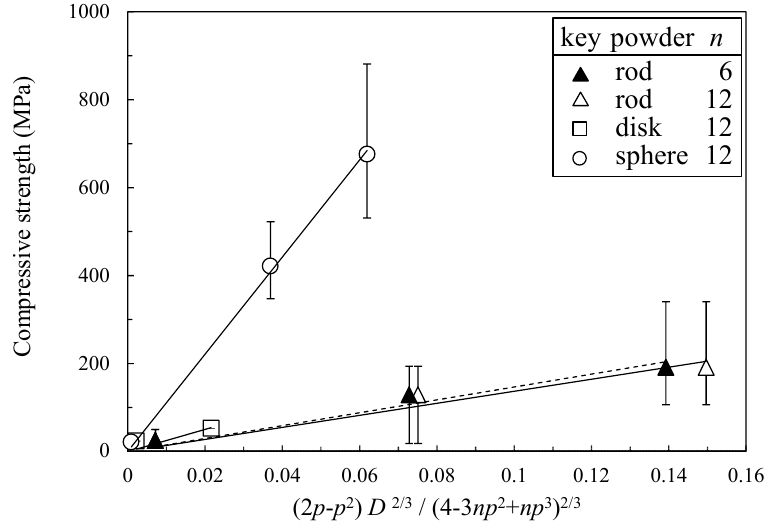
Figure 6. Relation between compressive strength and the right term of Equation (13) associated with grain boundary area.